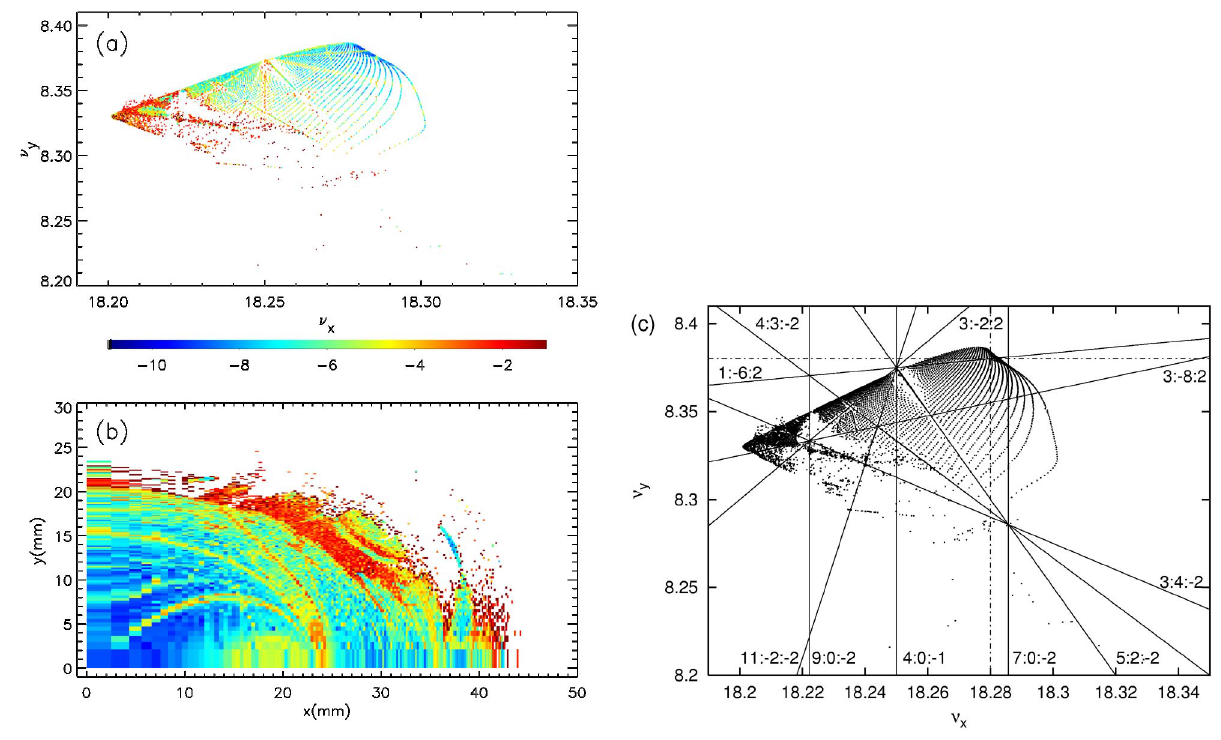
(cid:1) 10 m and x